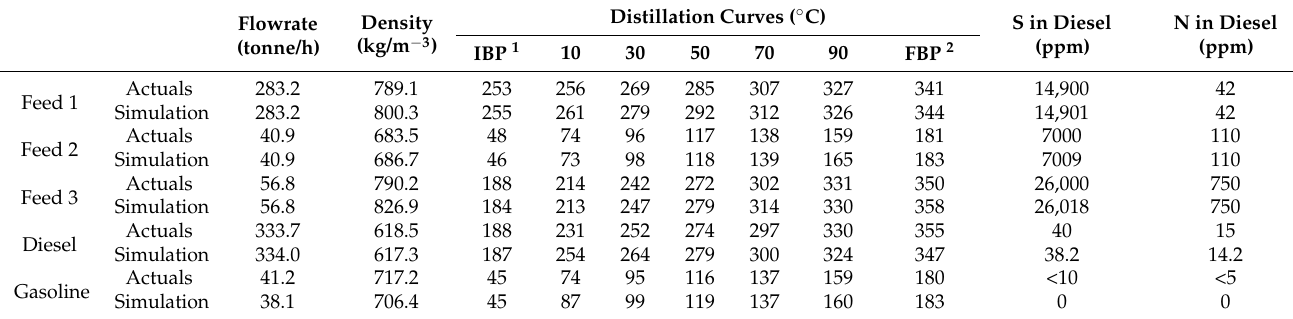
Table 3. Comparisons of feeds and products.